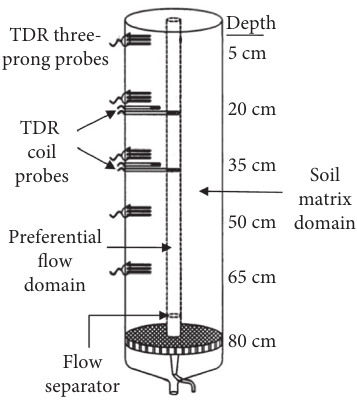
Figure 9: Soil column setup for studying the preferential flow [28].